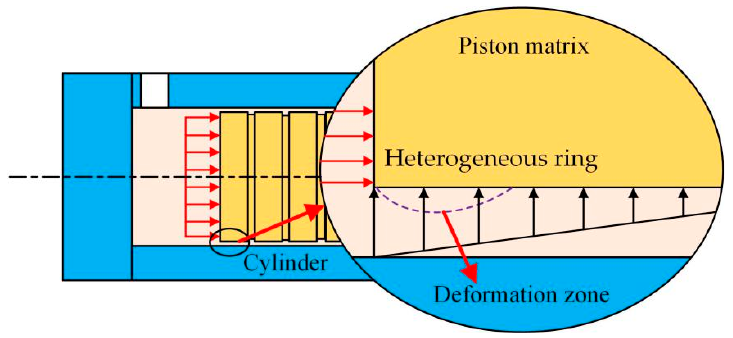
Figure 8. Schematic diagram of the heterogeneous ring [29].